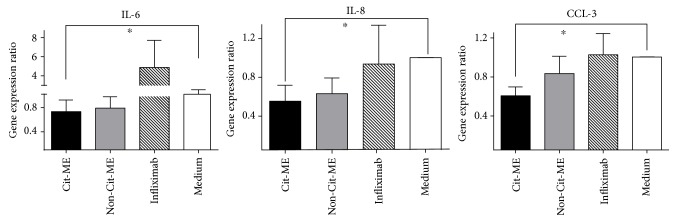
Cit-ME peptide downregulates IL-6, IL-8, and CCL-3 mRNA expression. PBMC of RA patients (n = 7–10) were cultured (5 × 105 cells/well) for 24 hours in the presence of Cit-ME (1.25 μg/mL). mRNA gene expression was determined by real-time RT-PCR. Results are presented as the mean ± SE percentage of gene expression, ∗p < 0.02.